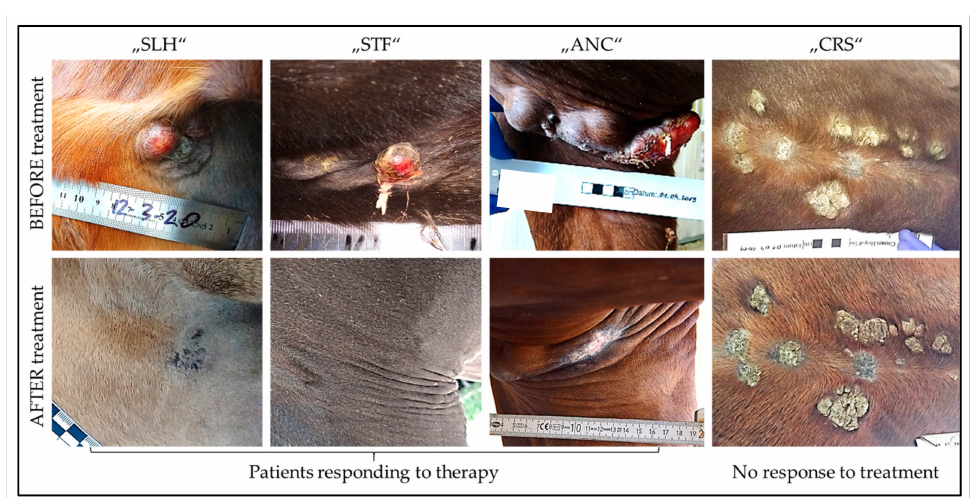
Figure 3. Influence of clinical sarcoid types on response to